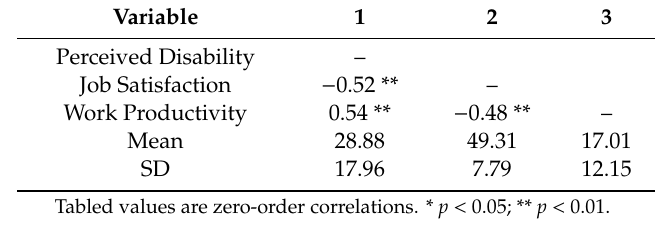
Table 2. Correlation Matrix, Means, and Standard Deviations of Study Measures.